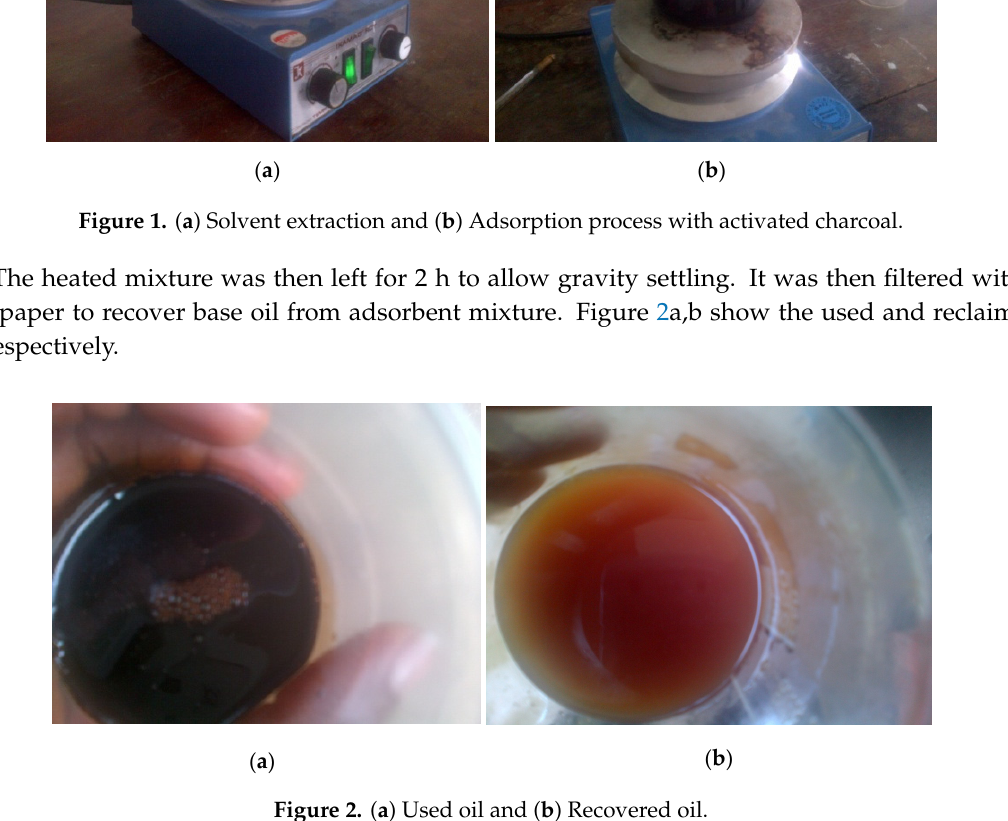
Figure 2. ( a ) Used oil and ( b ) Recovered oil.